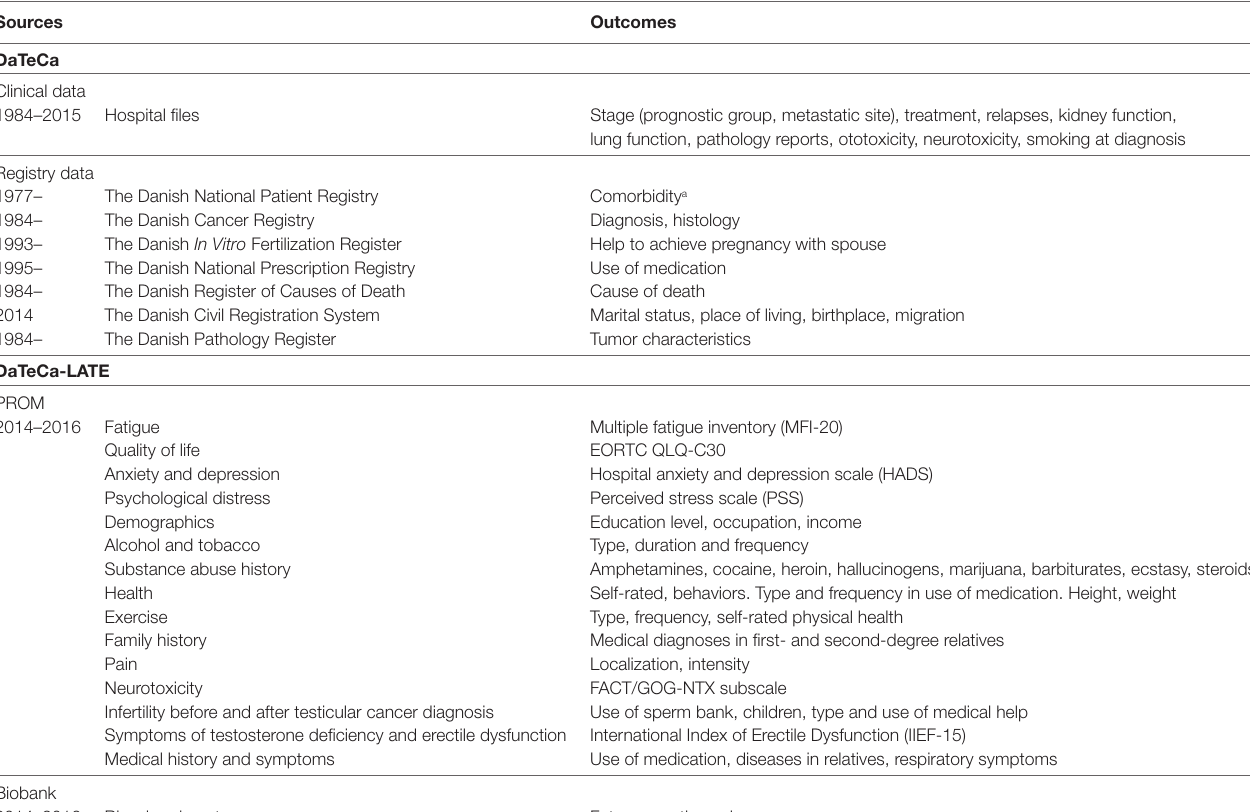
Table 2 | Outcomes measured in DaTeCa and DaTeCa-LATE surveys.